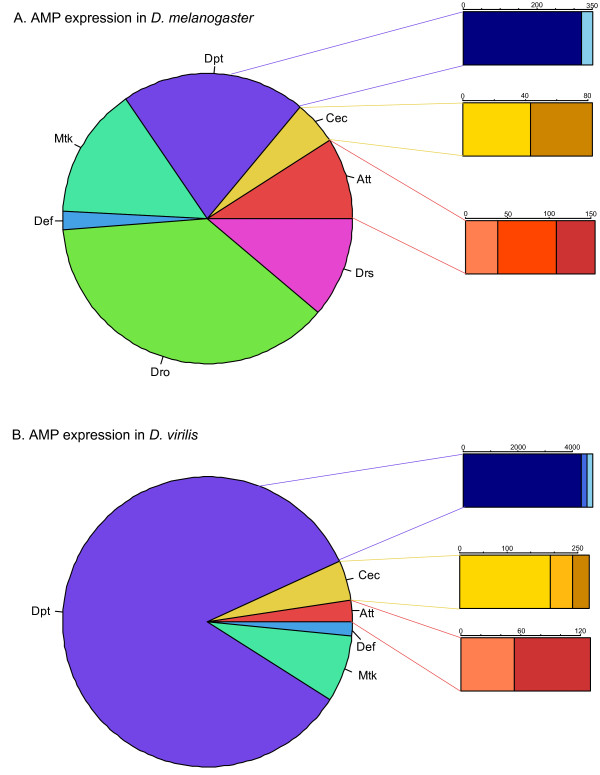
Relative expression of antimicrobial peptides in D. melanogaster and D. virilis after infection. Each pie chart shows the fraction of total reads from the infected samples that map to AMPs that are represented by a given peptide family. Each bar chart shows the reads mapped to individual families from the infected samples, with different colours representing individual members of each AMP family. A) D. melanogaster; B) D. virilis.